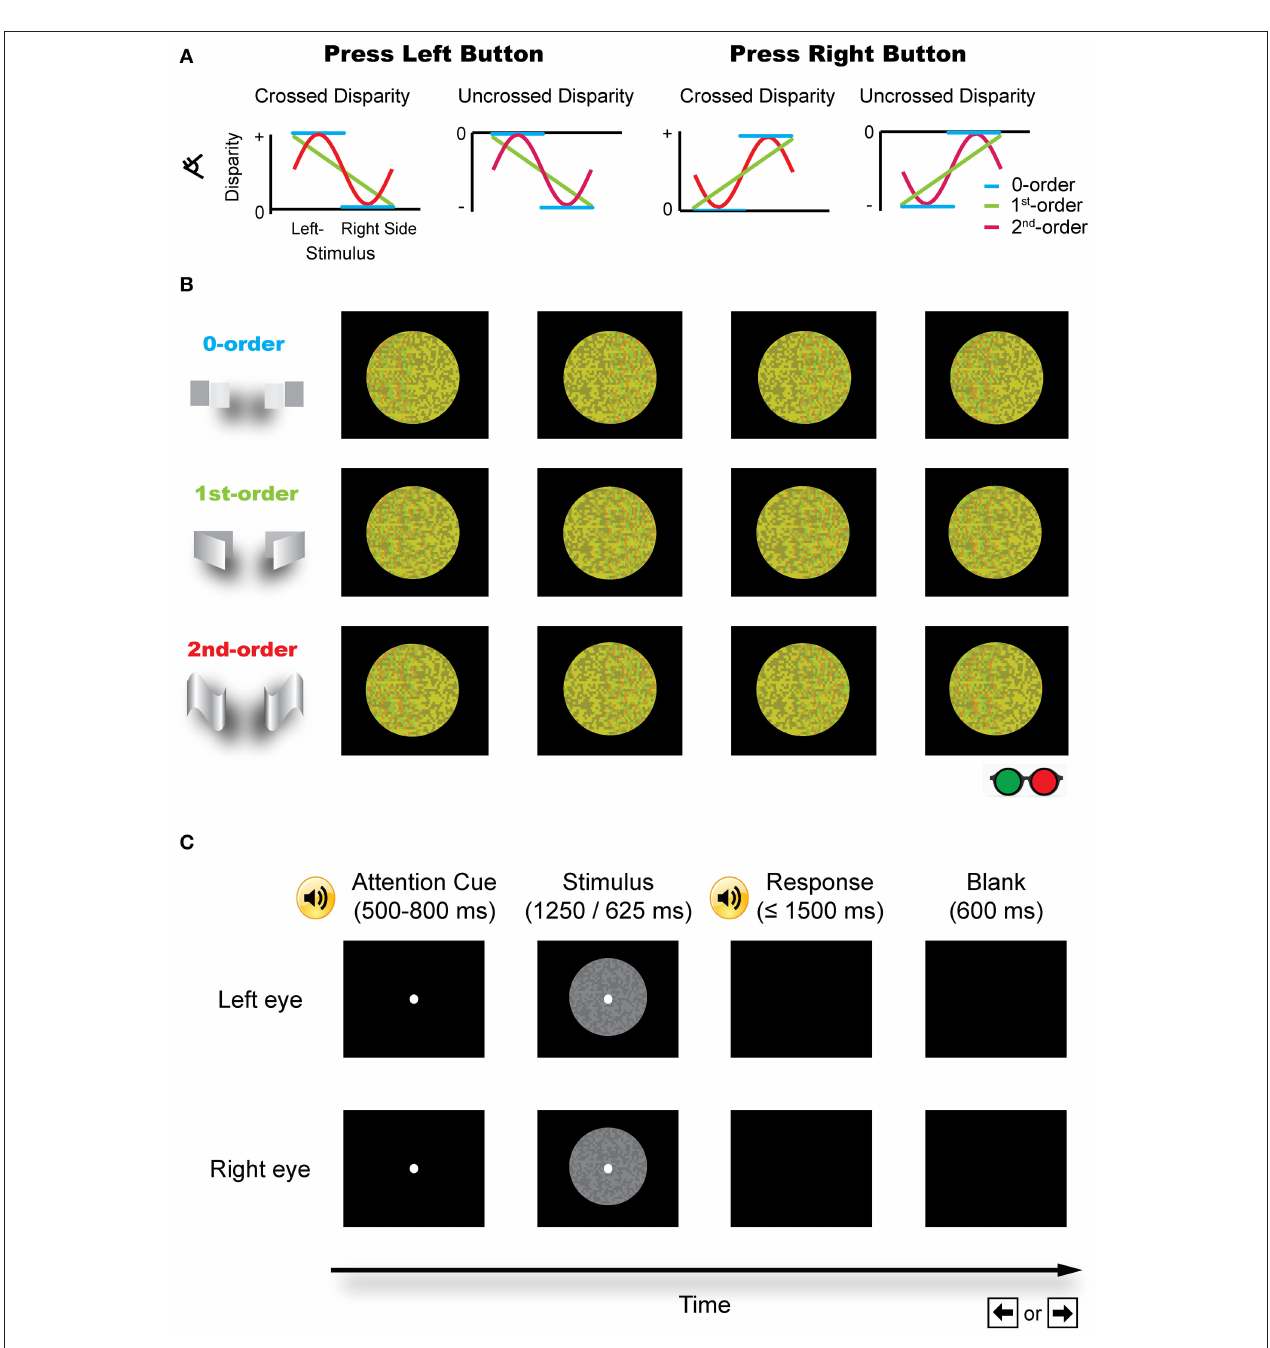
FIGURE 1 | Schematic illustration of the stimuli. (A) Different disparity profiles used in the zero-, first-, and second-order disparity condition. Subjects were asked to judge which half of an image was nearer by pressing a left or right button. (B) The red-green version of the example stimuli (for illustration purposes). (C) A typical trial procedure. Each trial started with an attention cue (500–800ms). A binocular disparity stimulus was presented for 1,250 or 625ms. After the response, a blank screen was presented for 600ms and the next trial started